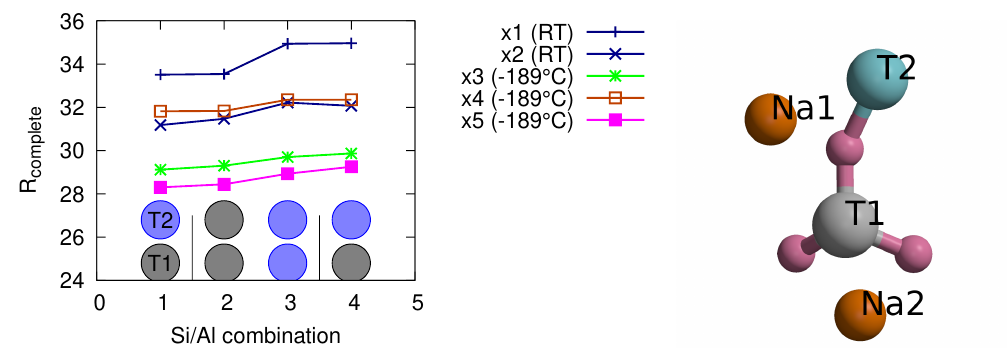
Figure 3. Right: R complete for all four possibilities to model T1 and T2 as aluminum (blue circle) and silicon (grey circle), respectively, plotted for all five crystals. The lowest R complete corresponds to the correct combination T1 = Si and T2 = Al. Atom coordinates and one isotropic ADP value were refined for each atom site without restraints, and until convergence was reached (no parameter drift). Left: Asymmetric unit of zeolite A with its two T-sites and two sodium ions (orange). We did not model the third, weakly occupied sodium ion